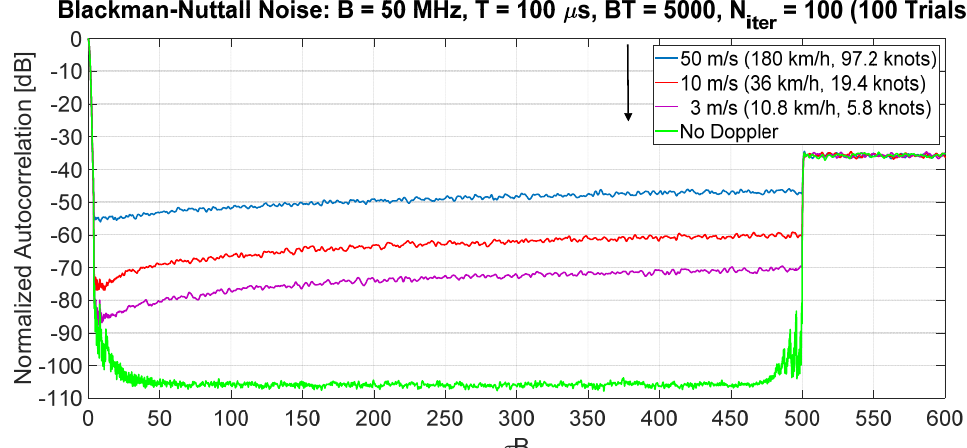
Figure 20. Normalized ACF with suppression sidelobes varying the Doppler velocity 3, 10, and 50 m / s. BT = 5000, n iter = 100. Mean on 100 trials.